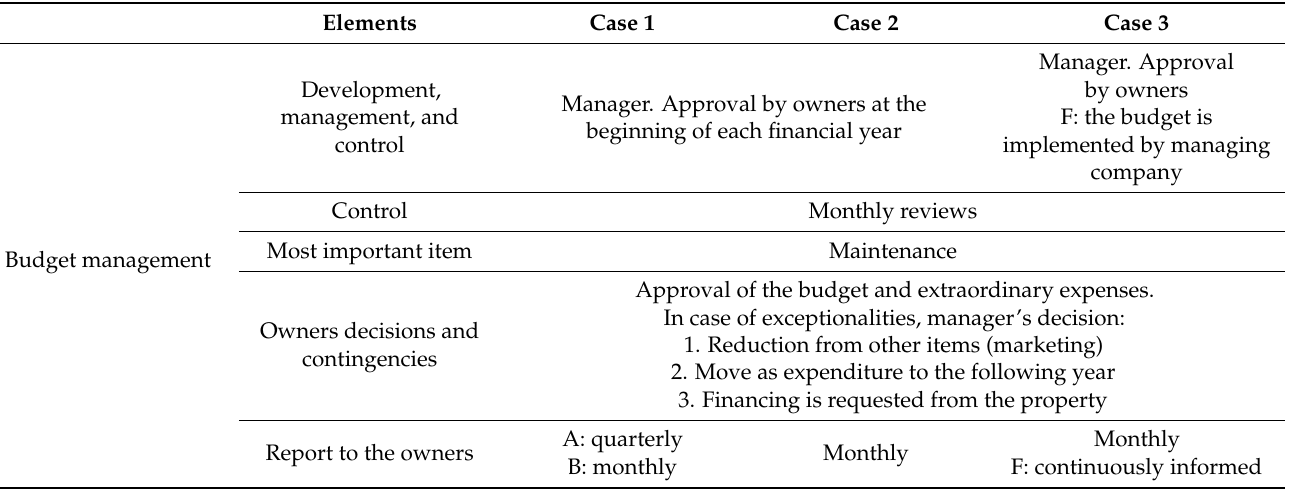
Table 4. Planning: budget management and control 1